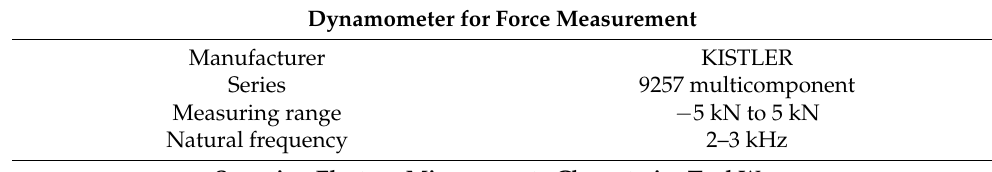
Table 3. Specifications of measuring